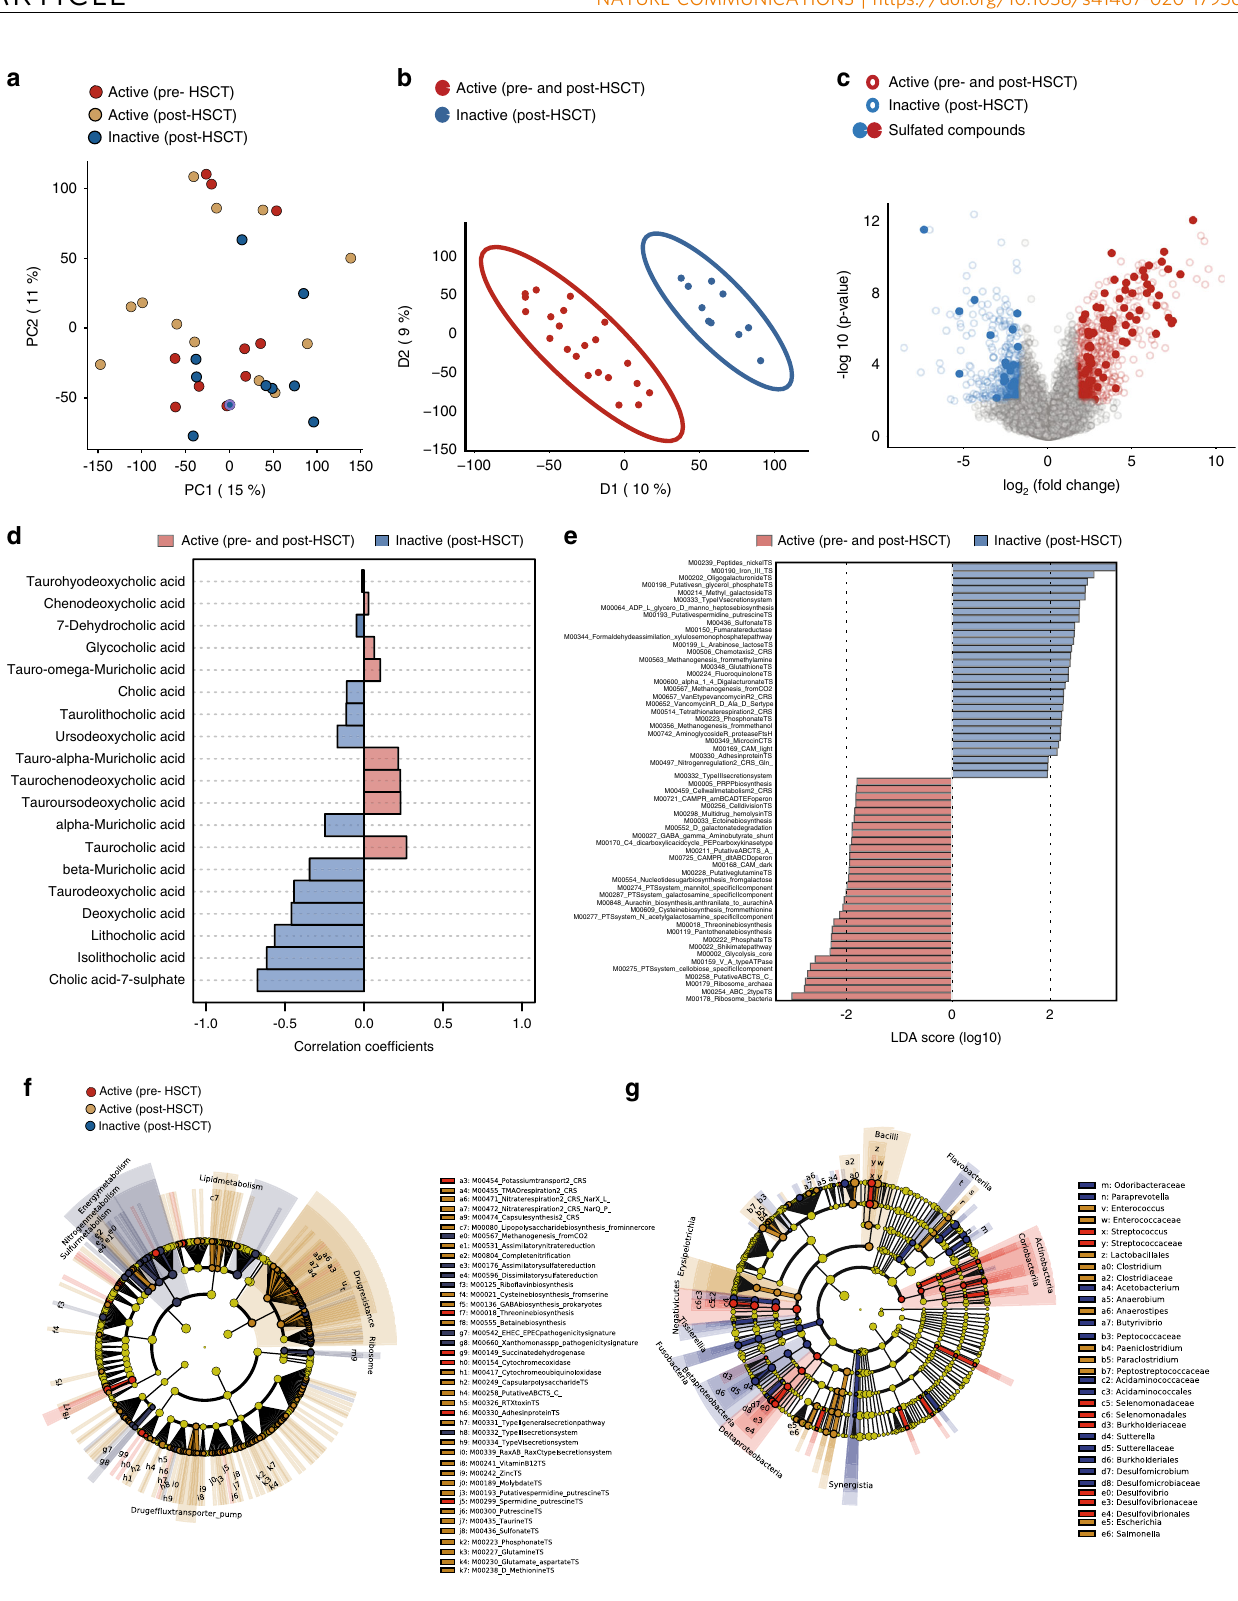
patients with active disease. In contrast, an enrichment of func- tional modules involved in assimilatory and dissimilatory sulfate reduction was observed in mice colonized with microbiota from patients with inactive disease (Supplementary Fig. 6b, c). The differential abundance of certain bacterial groups at family and